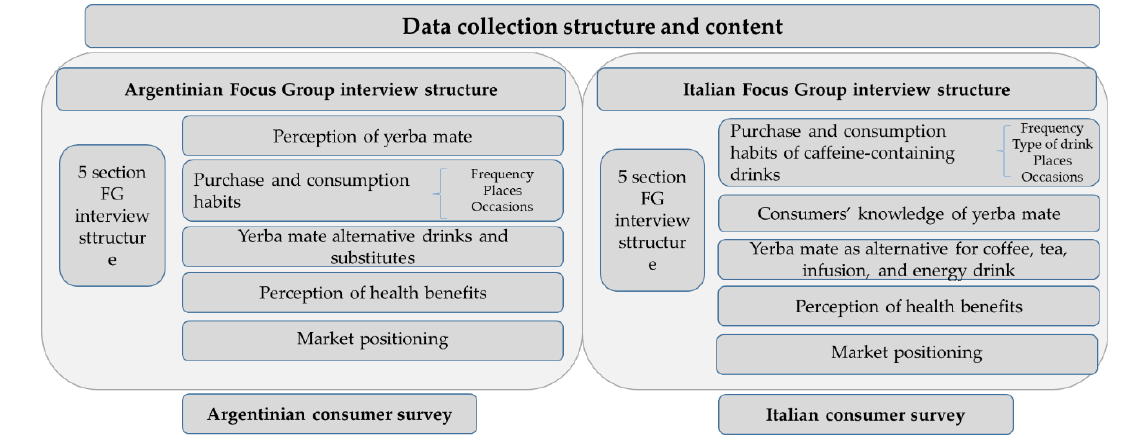
Figure 5. S teps of primary data collection phase.